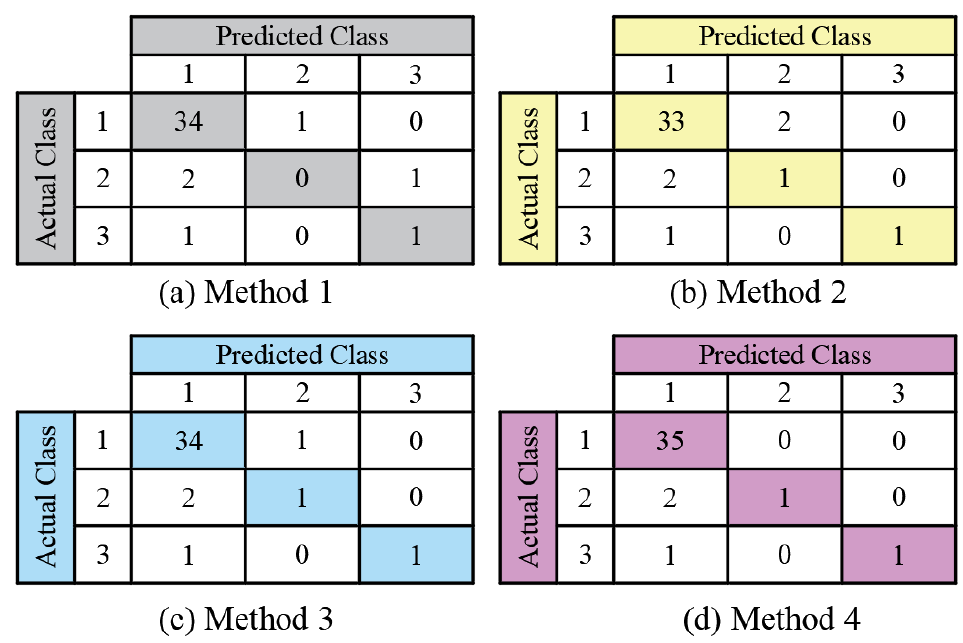
Figure 8. Confusion matrices for the test sets.